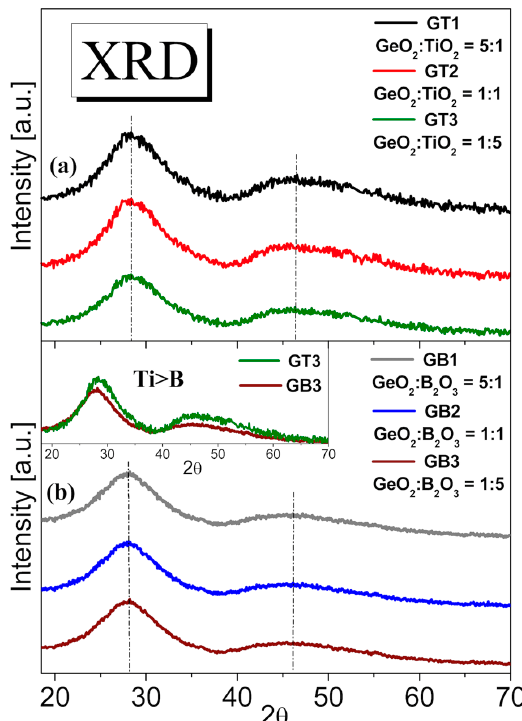
Figure 3. XRD profiles of barium gallo-germanate glasses containing various molar ratios TiO 2 ( a ) and B 2 O 3 ( b ). Insets show the X-ray diffraction intensity for GT3 (GeO 2 :TiO 2 = 1:5) and GB3 (GeO 2 :B 2 O 3 = 1:5) glass samples.